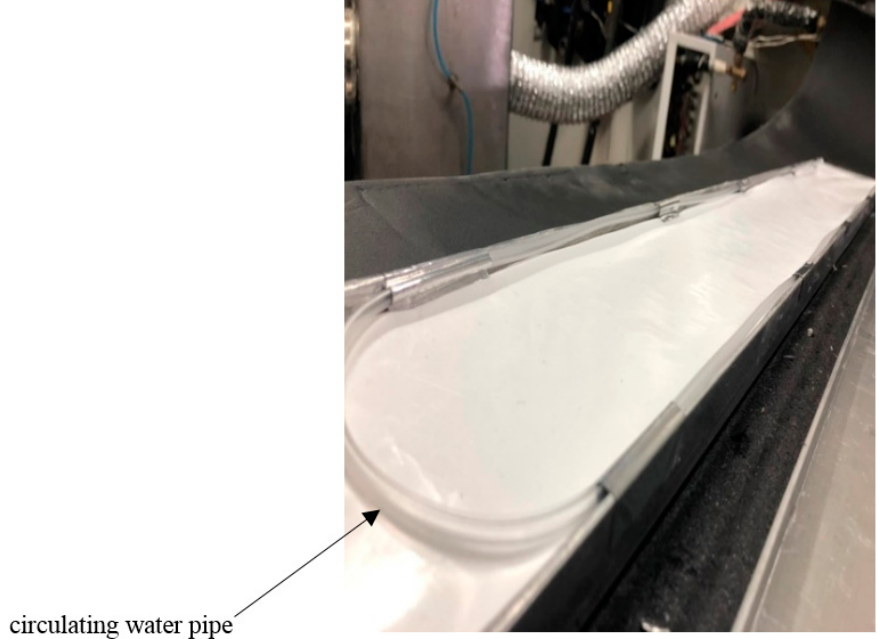
Figure 5. Configuration of circulating water pipe.